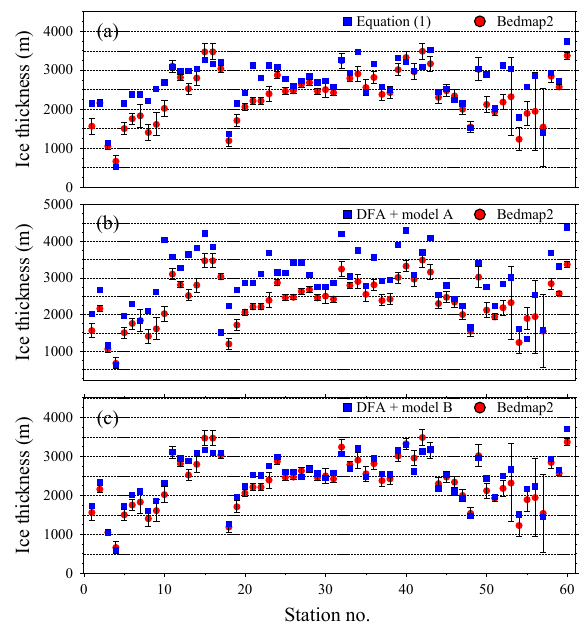
Figure 7. Ice thickness derived from the H / V method versus the reference Bedmap2 ice thickness. The station number of this fig- ure is in the same order as the stations listed in Table 1. The blue squares in panel (a) , (b) and (c) represent Eq. (1), DFA + Model A and DFA + Model B estimates, respectively. The red circles in each panel denote the Bedmap2 ice thickness and each Bedmap2 value is marked with its corresponding error bar obtained from the uncertainty grids (Fretwell et al.,